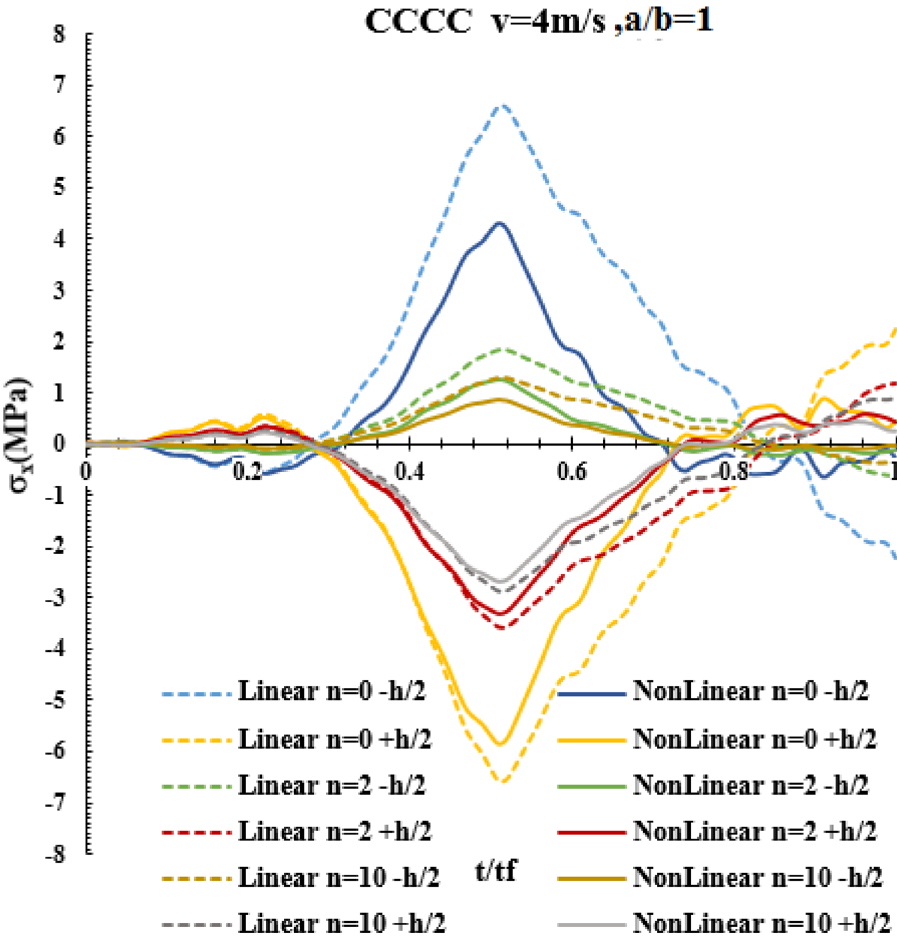
Fig. 19 The effect of material gradient index on transient dis- tribution of 𝜎 xx for center-point of the plate (CCCC, v = 4